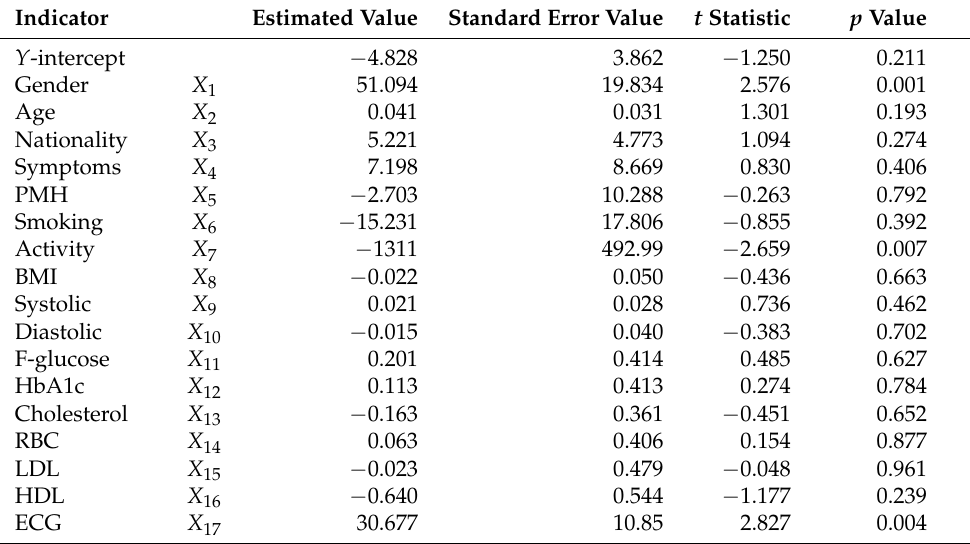
Table 11. Estimated coefficients for the variable indicated and their p-values; see abbreviations in